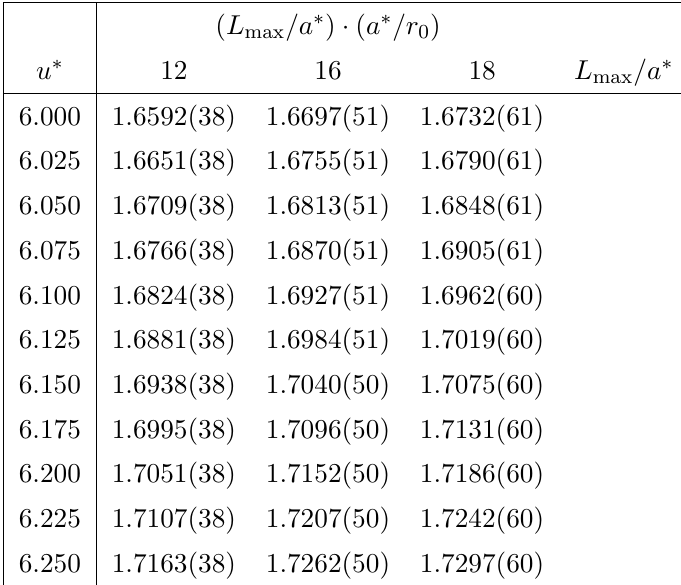
Table 13 . L max =r 0 at each u (cid:3)